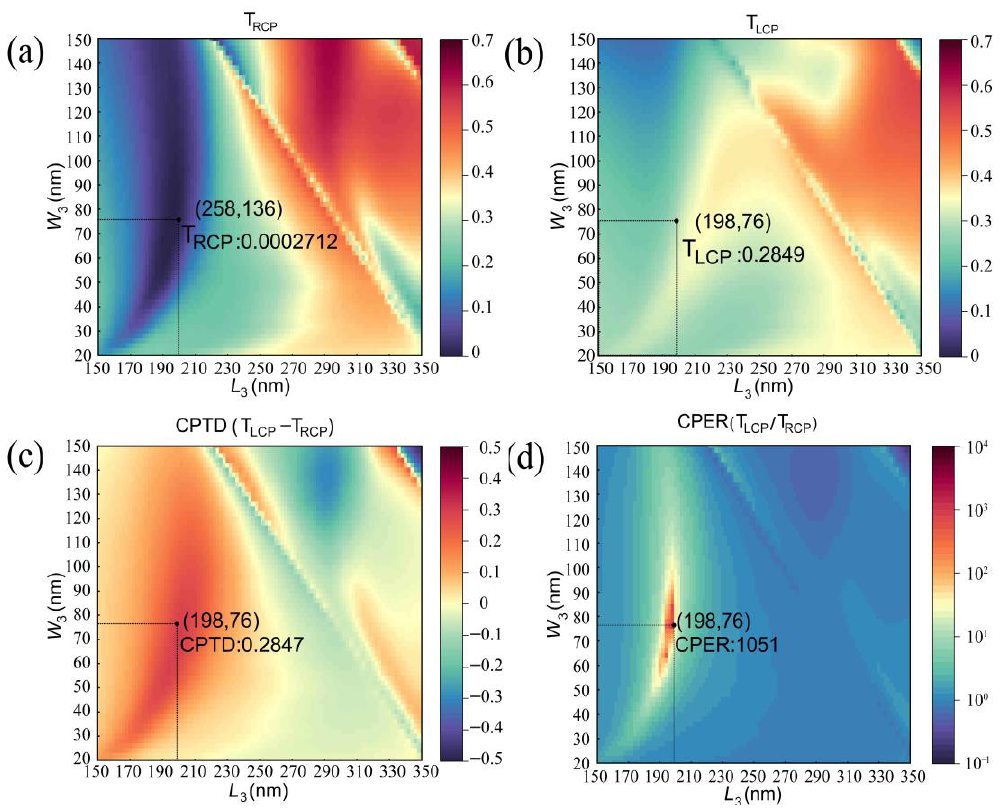
Figure 5. Simulated optical properties of the composite structures. ( a ) The transmittance of the right- handed circularly polarized light (T RCP ). ( b ) The transmittance of the left-handed circularly polarized light (T LCP ). ( c ) Circular polarization transmittance difference (CPTD). ( d ) Circular polarization extinction ratio